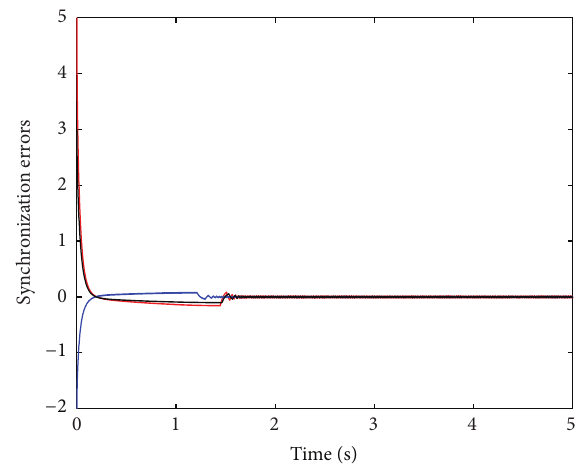
Figure 13: Synchronization errors states in the presence of system- atic uncertainties and external disturbances with 𝛼 = 1 (red line represents the first error state 𝑒 1 , blue line represents the second error state 𝑒 2 , and black line represents the third error state 𝑒 3 ).